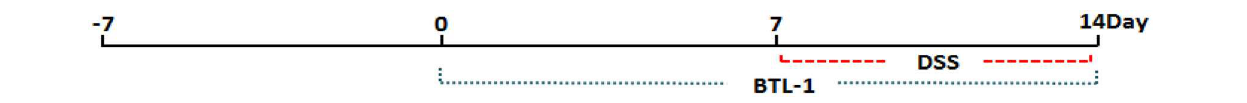
FIGURE 1 | Mice treatment scheme.